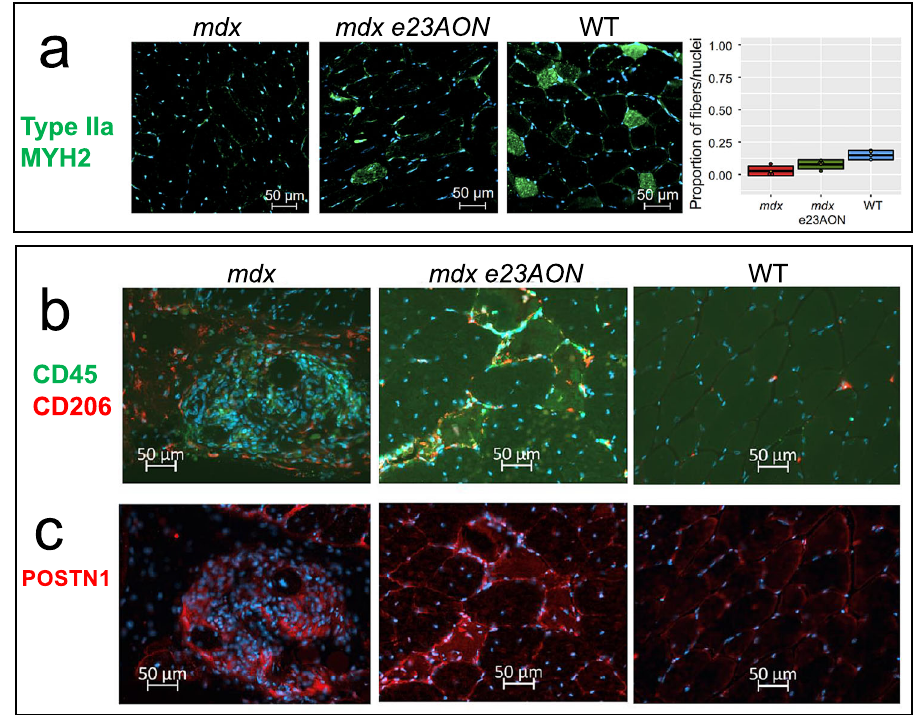
Fig. 6 Immuno fl uorescence staining of muscle cross sections of some identi fi ed differentially expressed gene products. a MYH2 staining reveals preferential reduction in Type IIa Fibers in mdx and recovery in e23AON-treated mdx . Example immuno fl uorescence images of staining for each mouse are shown. MYH2 were stained (Green) in muscle sections from WT ( n = 3), mdx e23AON ( n = 4), and mdx ( n = 4) mice, in combination with DAPI (blue) to mark nuclei. Quanti fi cation of the proportion of type IIa fi bers was performed by counting the number of MYH2 + fi bers out of >200 fi bers per section from well preserved sections from each mouse ( mdx n = 4, mdx e23AON n = 4, WT n = 3). Thick lines on box plot shows mean proportion across all samples in each treatment condition, box shows 1 standard deviation. Individual datapoints are shown as black dots on plot. Raw data values are listed in Supplementary Data 7. Red dot indicates the proportion myonuclei for each respective fi ber type for each mouse type from snRNASeq. b e23AON treatment promotes M2 expansion. CD45 (green) and CD206 (red) were stained in muscle sections from WT ( n = 3), mdx e23AON ( n = 4), and mdx ( n = 4) mice, in combination with DAPI (blue) to mark nuclei. Regions were chosen to best re fl ect number and type of immune cells present and differences in levels of immune in fi ltration occurring with disease and treatment. While untreated mdx mice show massive muscle in fi ltration of CD45 + non-M2 immune cells (green, b ), e23AON-treated mdx mice show increased M2 cells as a percent of total CD45 + immune cells (red, b ). c POSTN1 protein was probed in fi brotic lesions in sections from WT ( n = 3), mdx e23AON ( n = 4), and mdx ( n = 4) mice. POSTN1 expression within fi brotic lesions was highest in mdx , and was reduced in mdx e23AON, and absent in WT